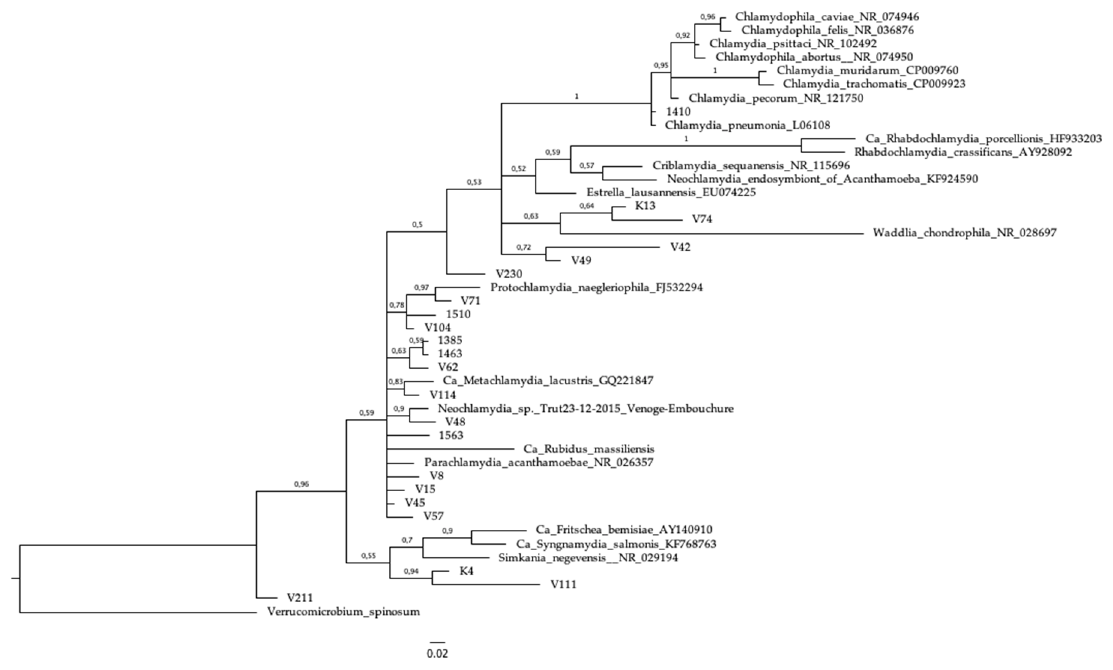
Figure 1. Bayesian posterior probability tree of the sequences in this study along with reference sequences and Verrucomicrobium spinosum as an outgroup to root the tree. Some clades are well resolved whereas some are weakly, probably due to short sequence length. The scale bar represents 2% genetic divergence.